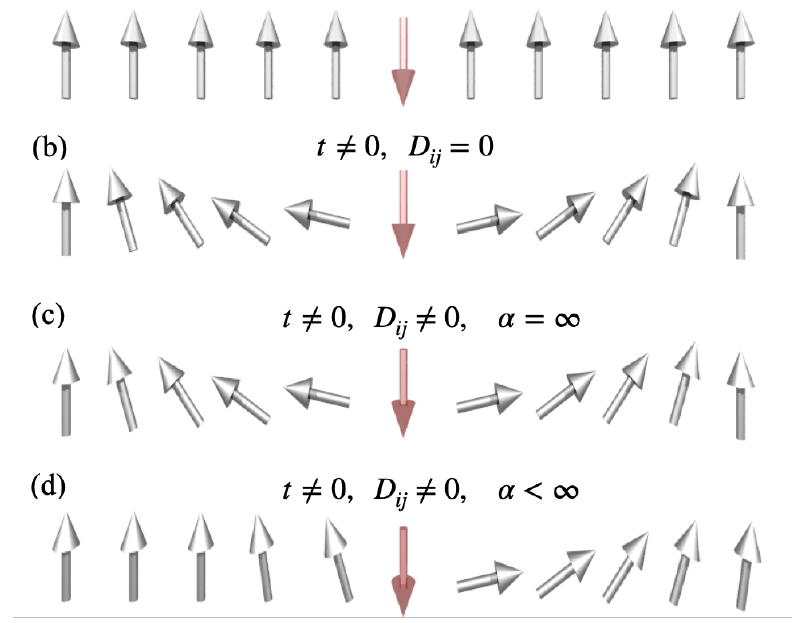
Figure 1: (colour online) Sketch of the protocol. (a) at time t = 0 initializing state with all spins aligned in the z -direction, and perturb single spin at the middle of chain by reversing it direction. Probing local spin evolution at later times (b) in the = 0 for all range of interaction, and in the presence absence of DM interaction D ij (cid:54) = 0 for (c) nearest-neibour interaction α = ∞ , (d) at finite of DM interaction D ij α < ∞ but significant in long-range regime α →